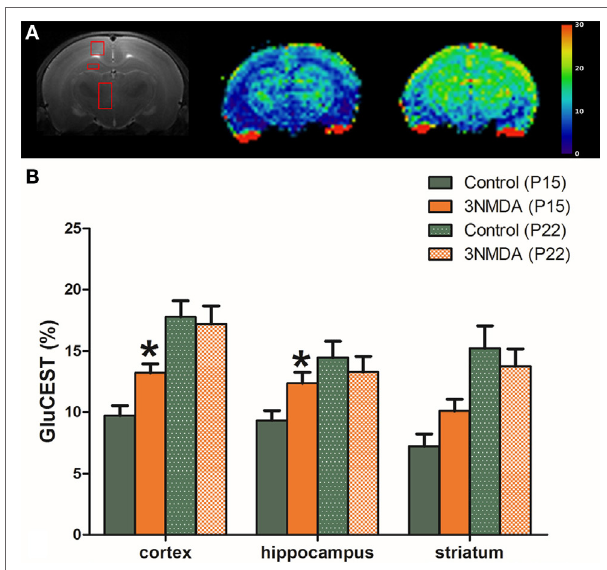
Figure 2 | (a) After three rounds of spasms on postnatal day (P) 12, 13, and 15, glutamate chemical exchange saturation transfer (GluCEST, %) levels were measured in the cortex, hippocampus, and striatum on P15. (B) There were significant increases in the GluCEST (%) of rats with three rounds of N -methyl- d -aspartate (NMDA)-induced spasms compared with controls in all measured areas. A developmental increase in the GluCEST (%) from P15 to P22 was noted, and there was no significant difference in the GluCEST (%) between rats with spasms and